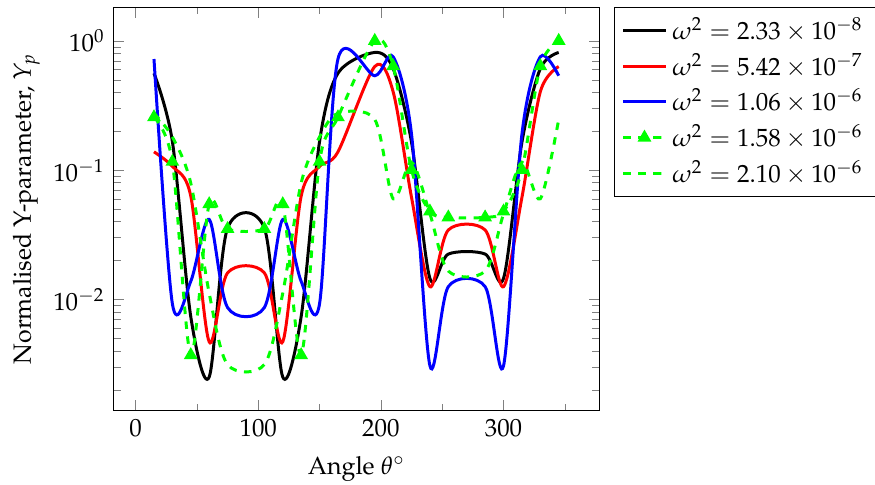
Figure 5. Y-parameter ( Y p ) as a function of angle ( θ ◦ ) at a fixed time t = 10 d and varying separation constant ( ω 2 ).